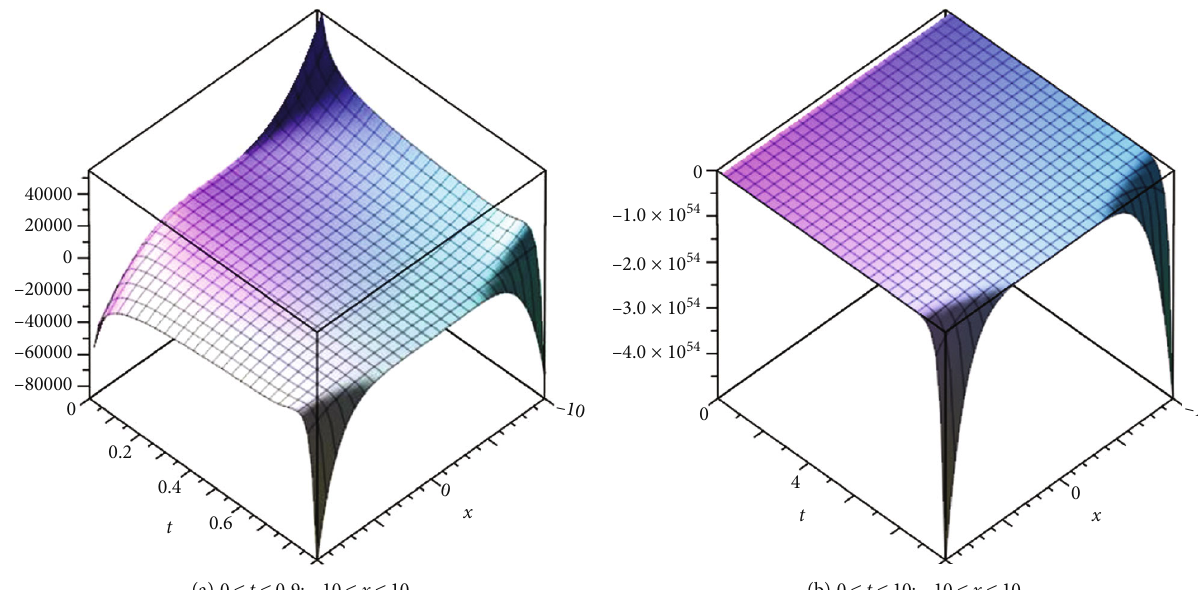
= 2, a = 5, a = 1 0 1 2